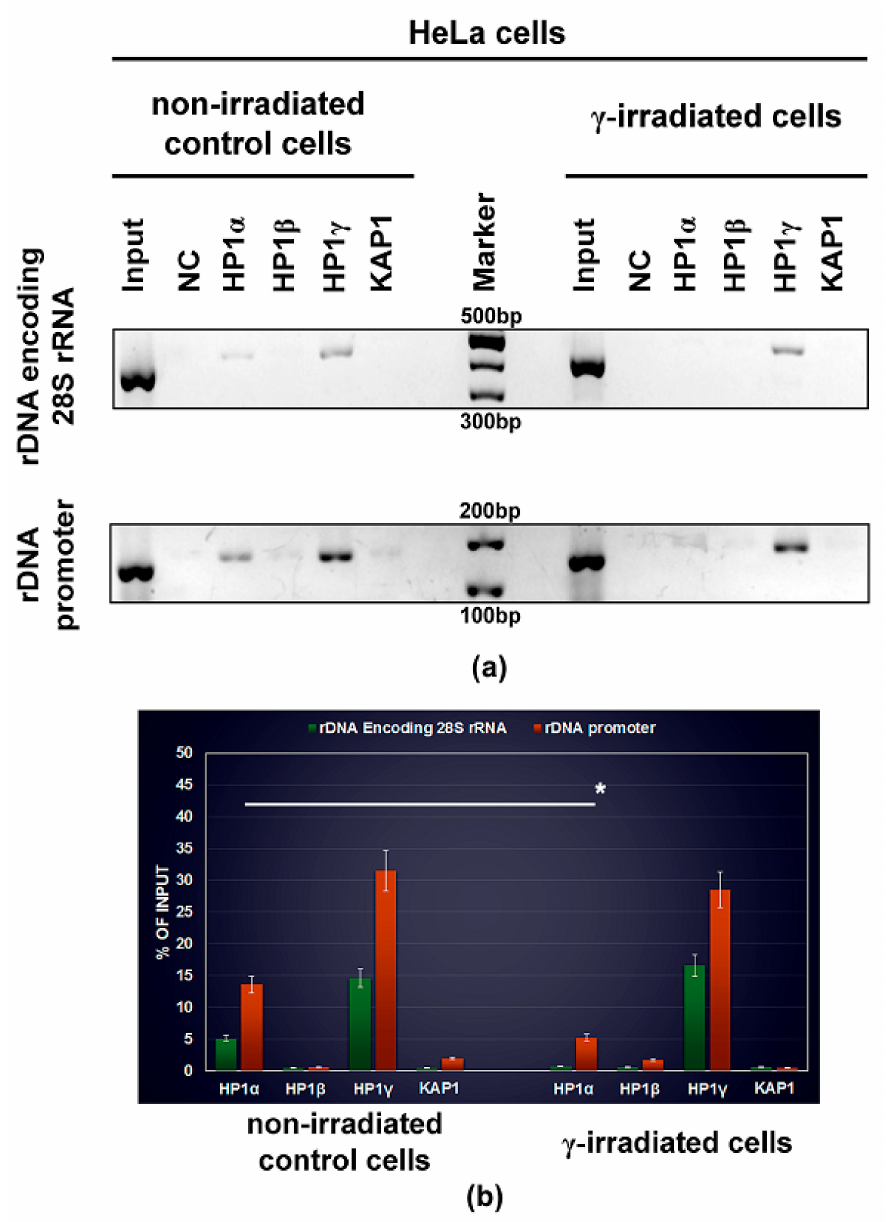
Figure 2. ChIP-polymerase chain reaction (ChIP-PCR) analysis of HP1 α , HP1 β , HP1 γ , KAP1 abundance in ribosomal genes. ( a ) The analysis was performed in non-treated human cervix adenocarcinoma (HeLa) cells, and cells irradiated by 5 Gy of γ -rays. Cells were harvested 2 h after γ -irradiation. The highest density in rDNA encoding 28S rRNA and rDNA promoter region was observed for HP1 γ . ( b ) Quantification of fragment densities, shown in panel ( a ), was done by ImageJ software. White asterisk shows statistically significant di ff erence, shown by Student’s t-test at p ≤ 0.05. 3.2. Mass Spectrometry Showed an Increased Level of HP1 β Ser88 Phosphorylation Induced by γ